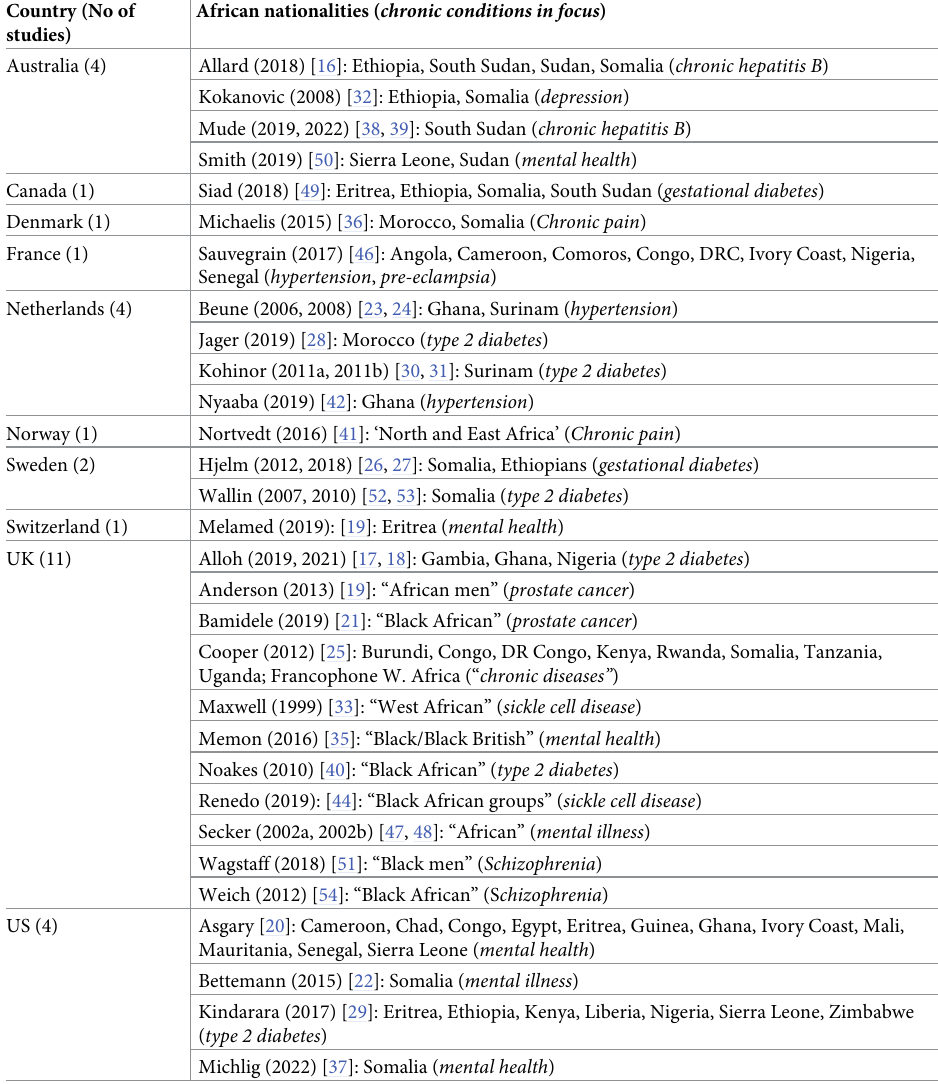
Table 3. Profile of participants’ African nationalities or countries of heritage and focal conditions.